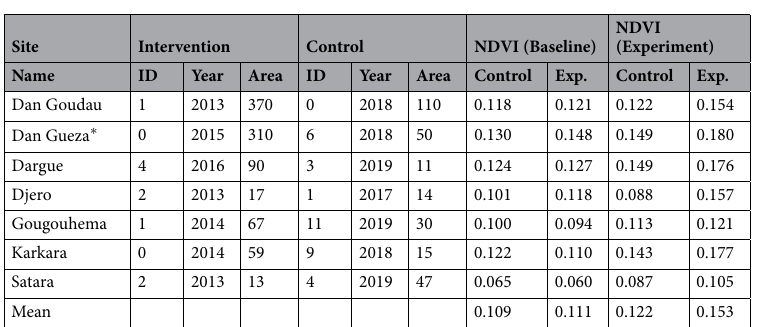
Table 2. Table showing the potential control and experiment sites (Pastoral/Agricole) with their coverage (ha) along with the mean NDVI values for baseline and experimental phase. [